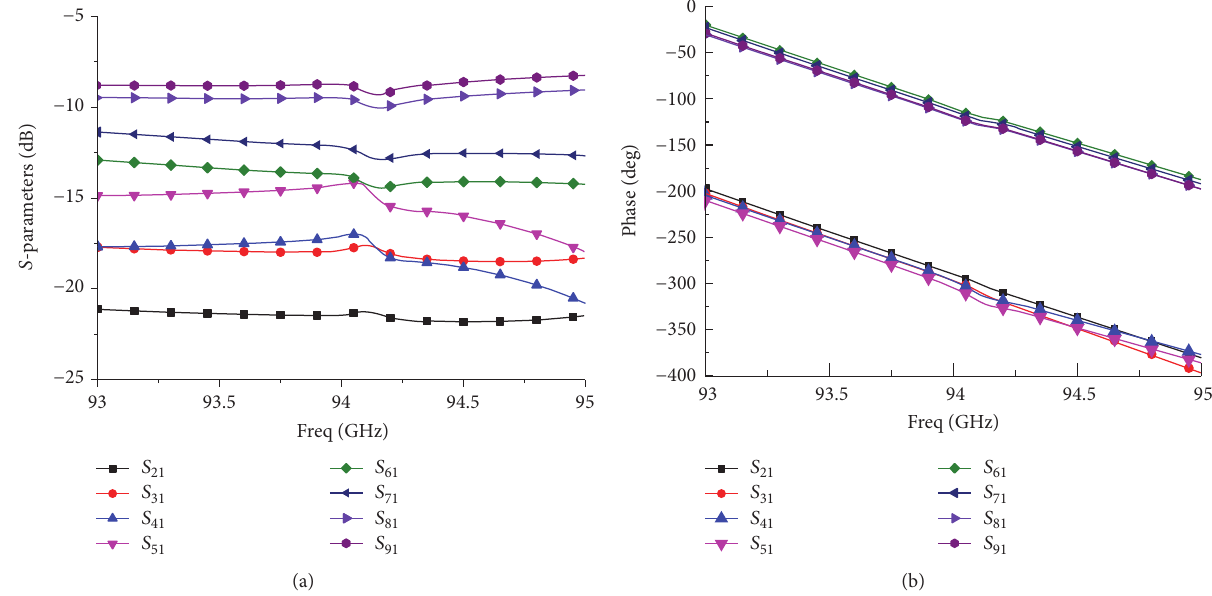
Figure 7: (a) Transmission coefficient of the sixteen-way feeding network. (b) Phase distribution of the sixteen-way feeding network.